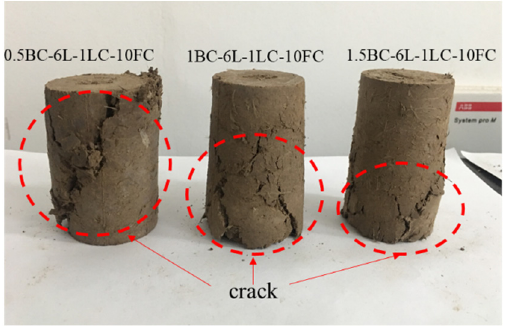
Figure 7. Failure forms of samples with different basalt fiber contents.